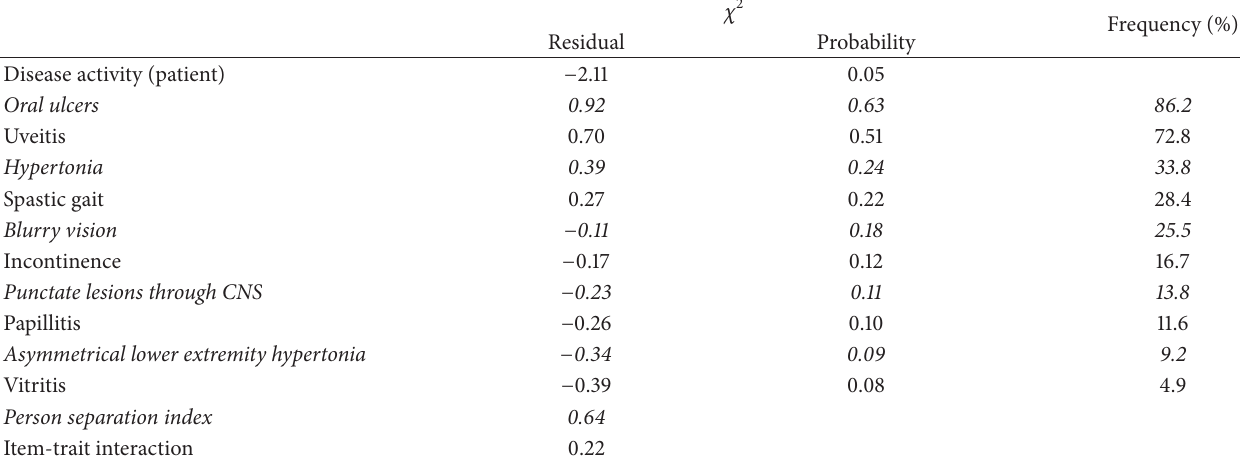
Table 3: Observatory clinical signs and symptoms associated with Behc¸et’s disease.